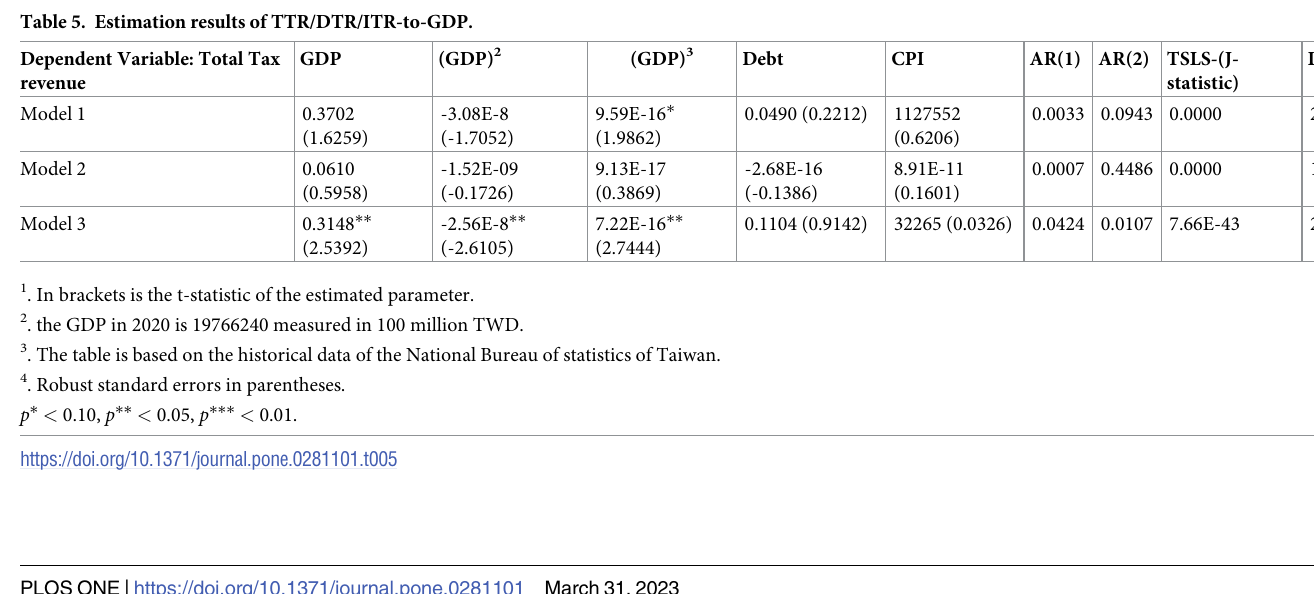
* The regression equations of model 1, model 2 and model 3 are derived from Table 4